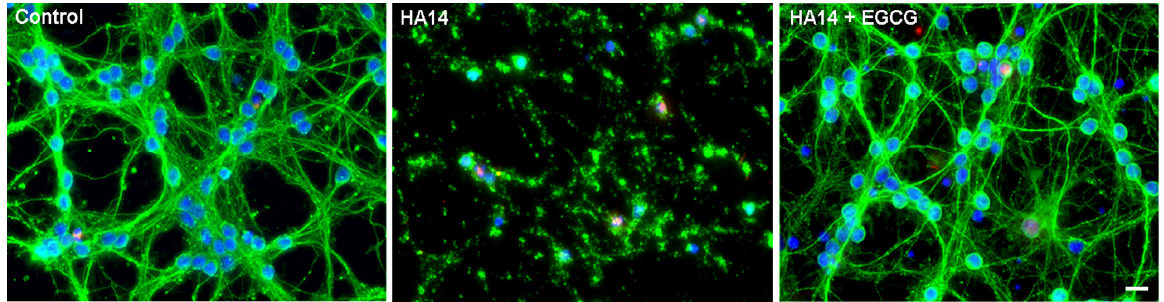
Figure 2. EGCG protects neurons from oxidative stress. Representative images of CGNs incubated for 24 hrs with the Bcl-2 inhibitor HA14-1 (15 M), HA14-1 + EGCG (25 M), or no treatment (Control). Immunocytochemistry was performed for β -tubulin (green) and active caspase-3 (red). Nuclei are stained with DAPI, blue. Scale bar; 10